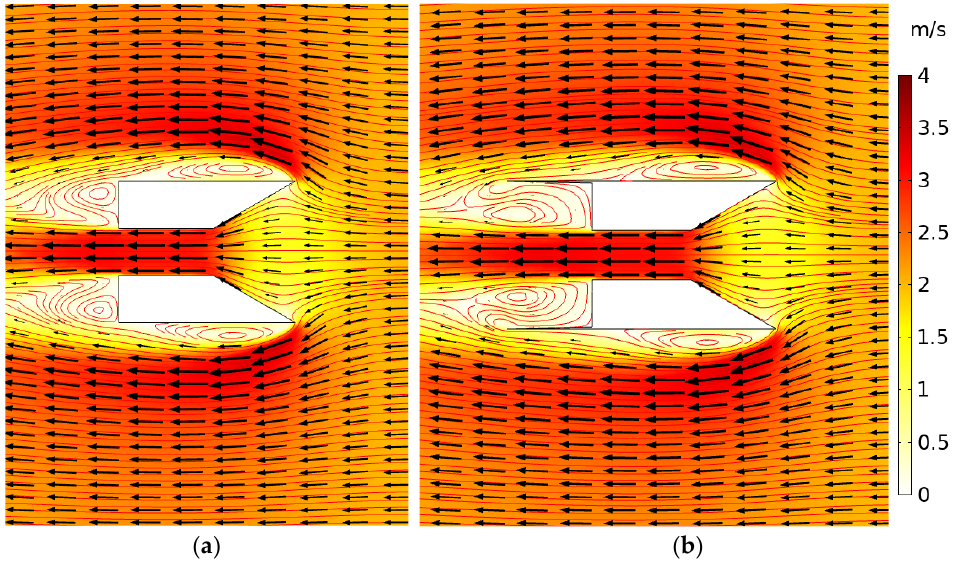
Figure 13. Flow velocity distribution by 2D FEA for duct scale models D1 ( a ), and D2 ( b ).